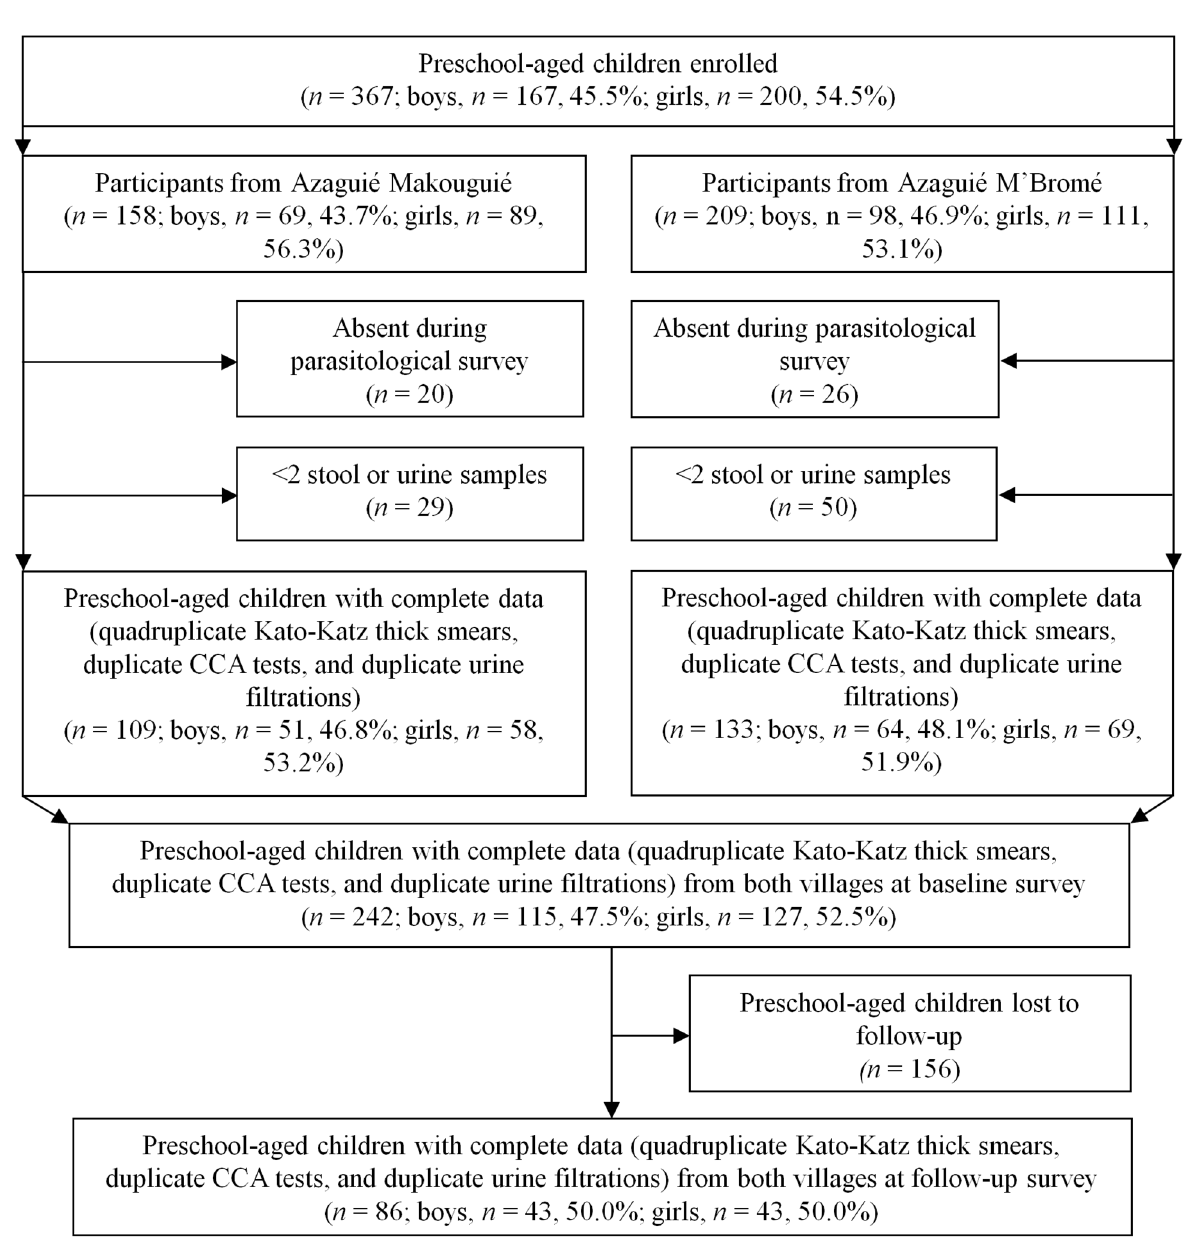
Figure 1. Flowchart showing study participation. Flowchart detailing study participation and adherence of preschool-aged children for submitting two stool and two urine samples for the diagnosis of S. mansoni , S. haematobium , and soil-transmitted helminths before and after administration of praziquantel in the two study villages in the Azaguie´ district, south Coˆte d’Ivoire, in August and September 2011. doi:10.1371/journal.pntd.0002109.g001 binary outcome variable (negative/positive), and a schistosome infection, with separate models for S. mansoni and S. haematobium .